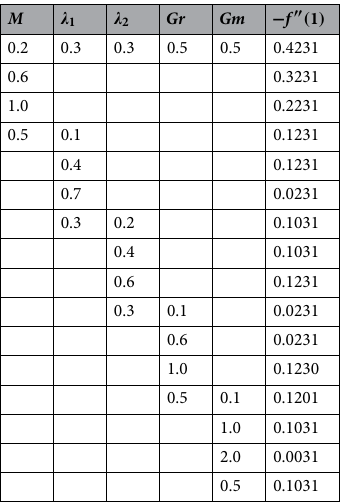
Table 2. Variation in skin friction coefficient